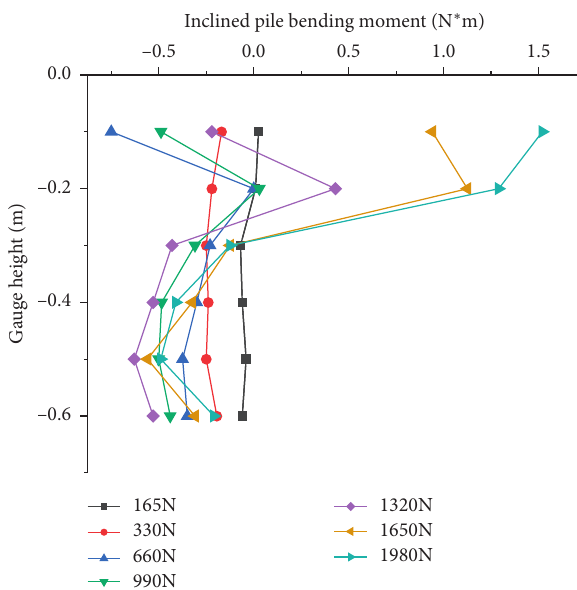
Figure 10: Curve of bending moment of the inclined pile under vertical load.